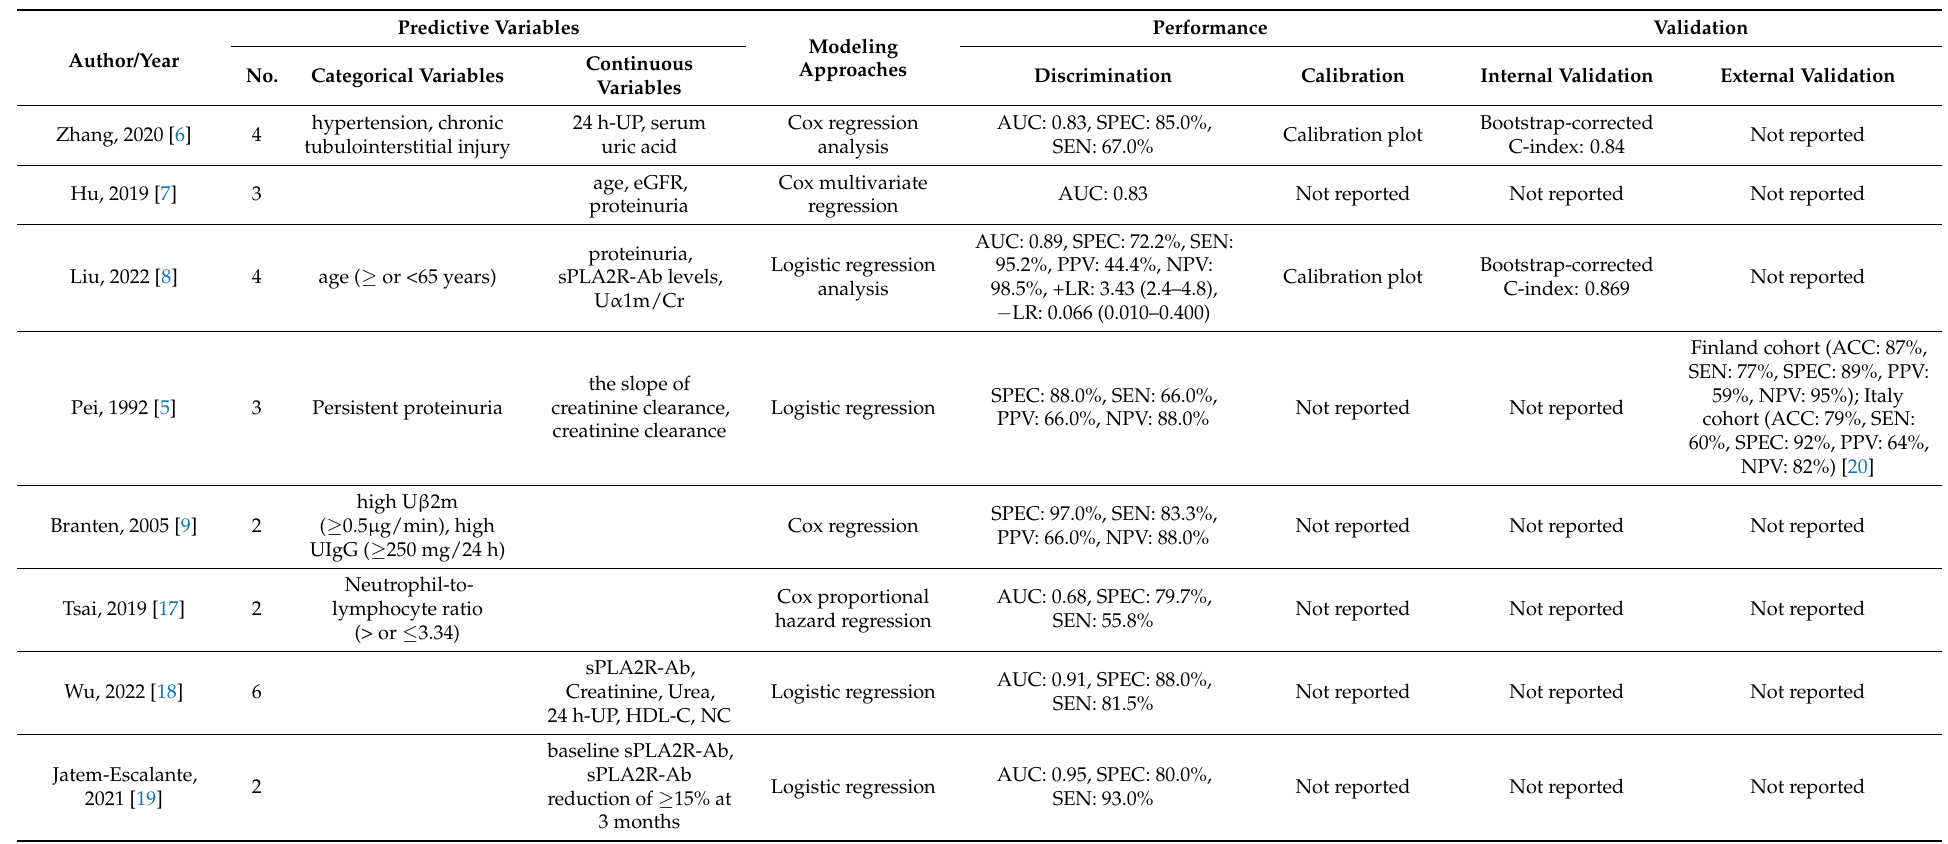
Table 2. Performance assessment of prognostic prediction models for